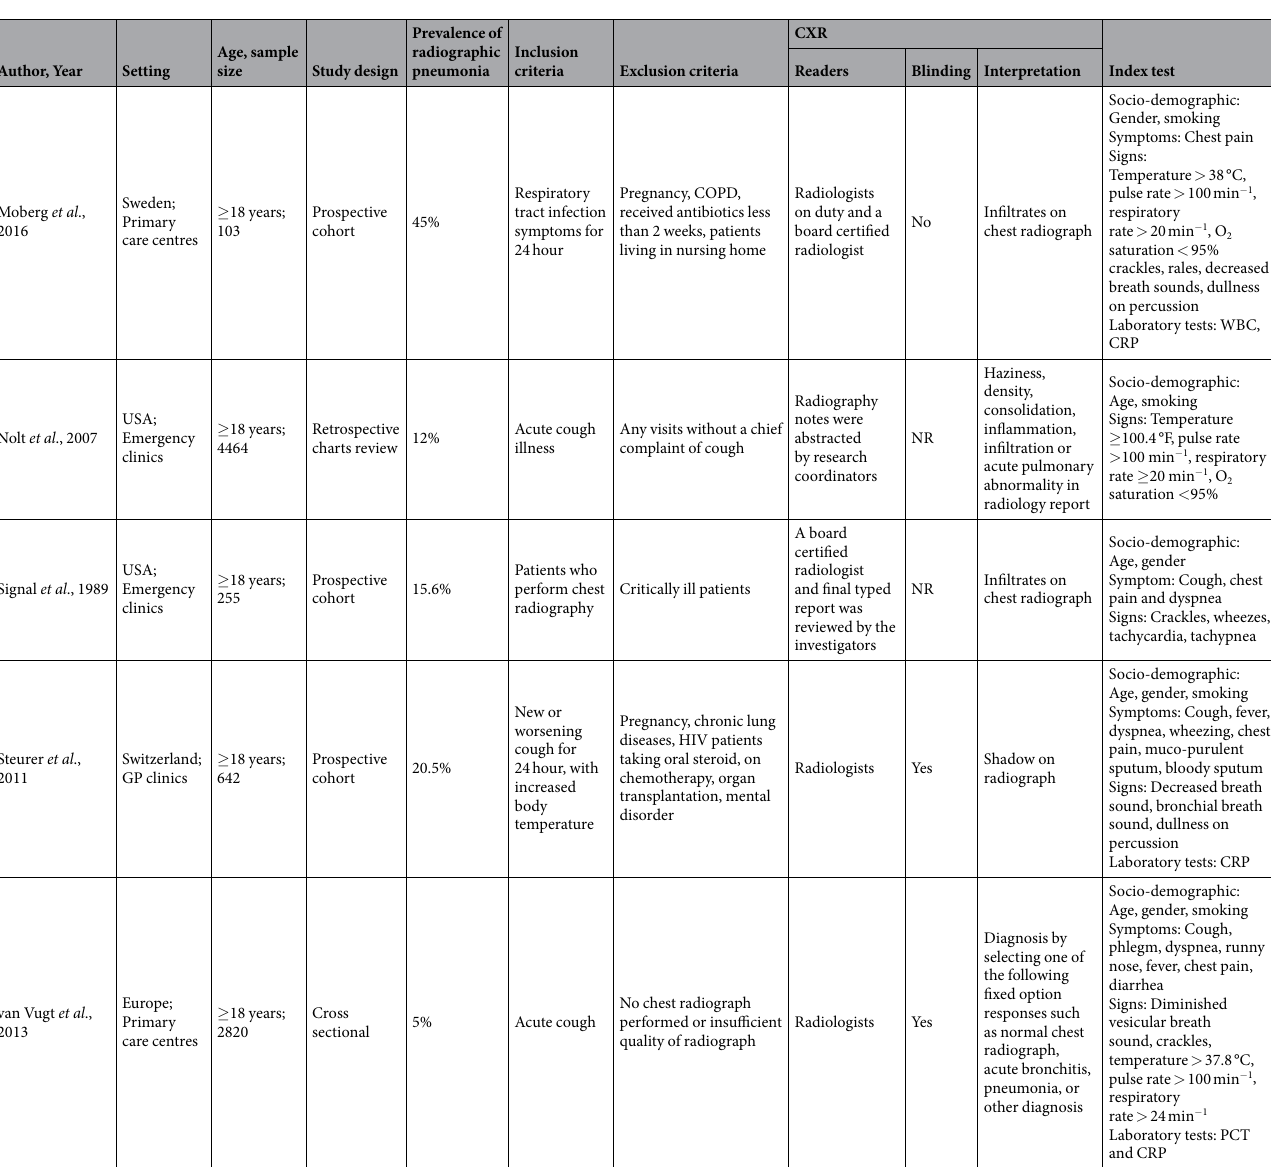
summary estimates of each index test’s diagnostic performance measures (sensitivity, specificity, positive, negative likelihood ratio and diagnostic odds ratio) are shown in Table 2. Among the index tests, cough had high sensitiv-